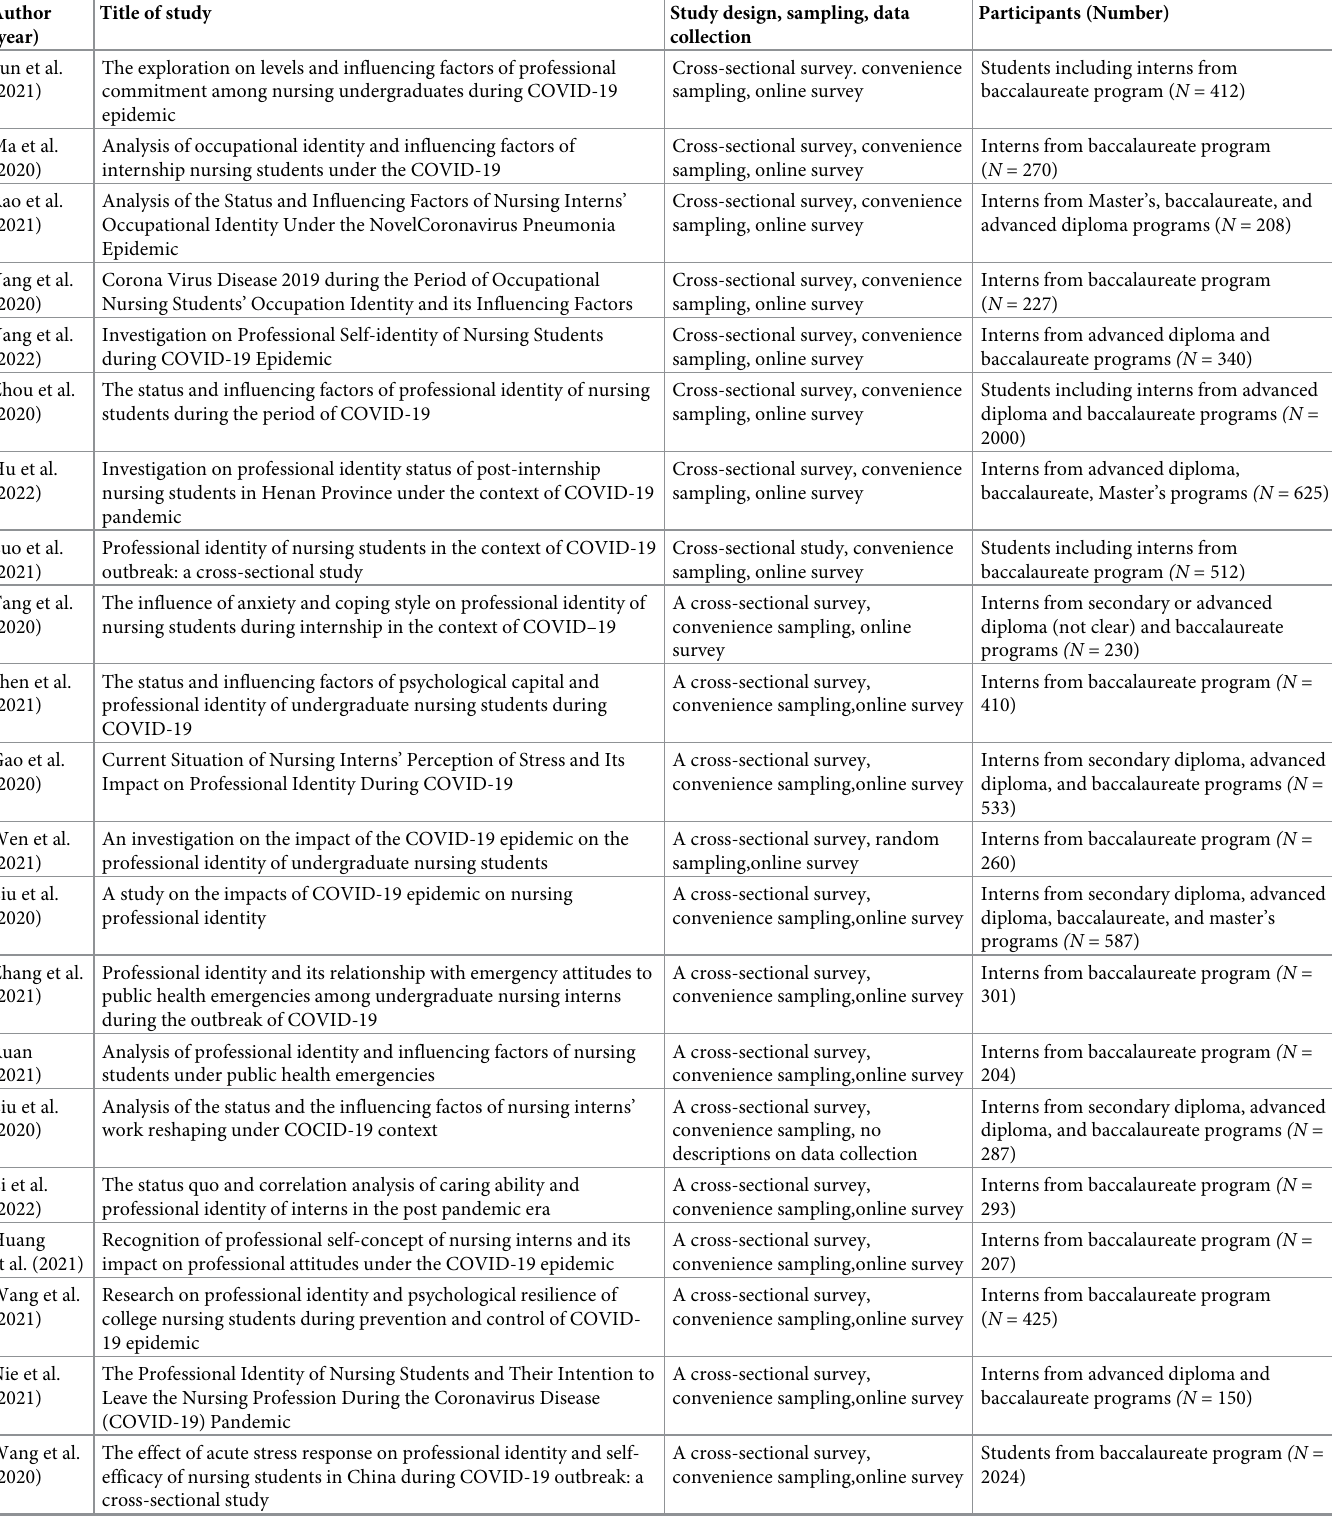
Table 1. Basic information of included studies (N =